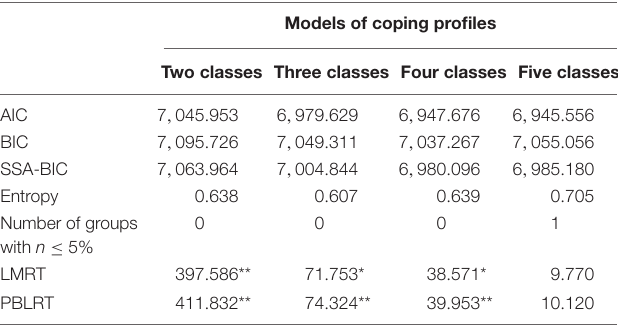
TABLE 2 | Statistics for the identification of fit of latent class models and classifying accuracy.